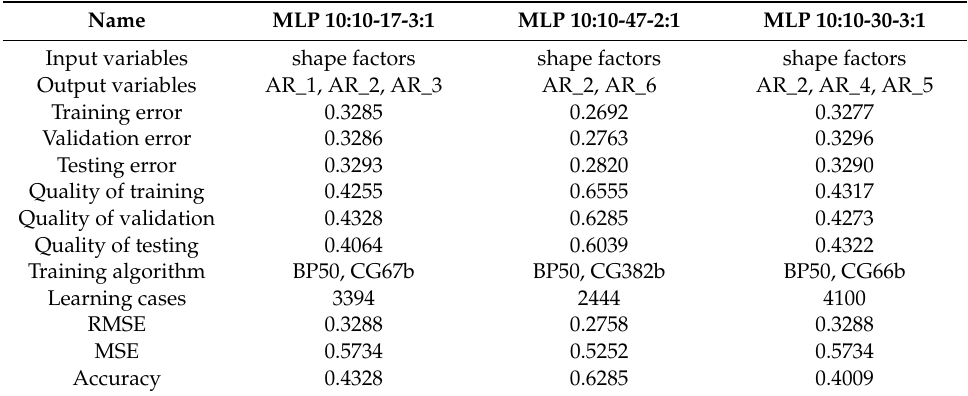
Table 5. Results of training process ANN shape coordinates.